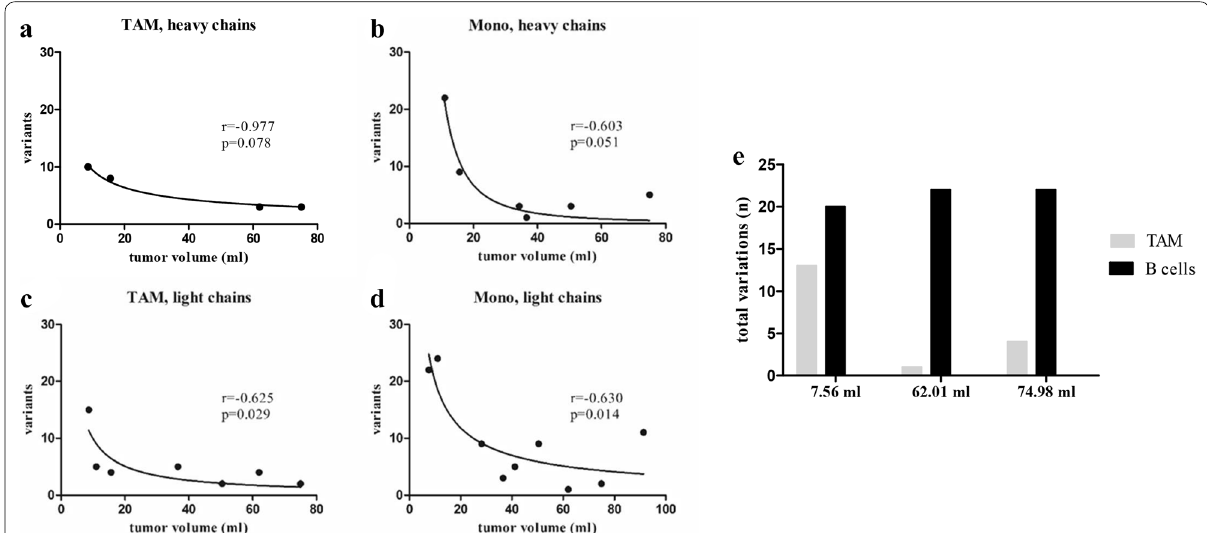
Fig. 3 Inverse correlation between the diversity of the immunoglobulin‑repertoire and the tumor volume. The total number of different immunoglobulin CDR3 variants from IgM‑ and IgG‑heavy chains expressed in tumor‑associated macrophages ( a ) and circulating monocytes ( b ) from glioblastoma patients is negatively correlated to the corresponding tumor volume. The inverse correlation of the total number of different CDR3 variants in tumor‑associated macrophages ( c ) and circulating monocytes ( d ) and the tumor volume was confirmed in the immunoglobulin light chain repertoires (Igκ‑ and Igλ). For all graphs ( a – d ) the respective correlation coefficients r and the p‑values are indicated. e The total number of different IgM and IgG CDR3 variants from tumor‑associated macrophages and B cells of three patients are shown. The immunoglobulin repertoires expressed by TAM show a higher repertoire diversity in the small tumor than in the large tumors. In contrast, the corresponding B cells of the same patients show a high repertoire diversity independent of the tumor